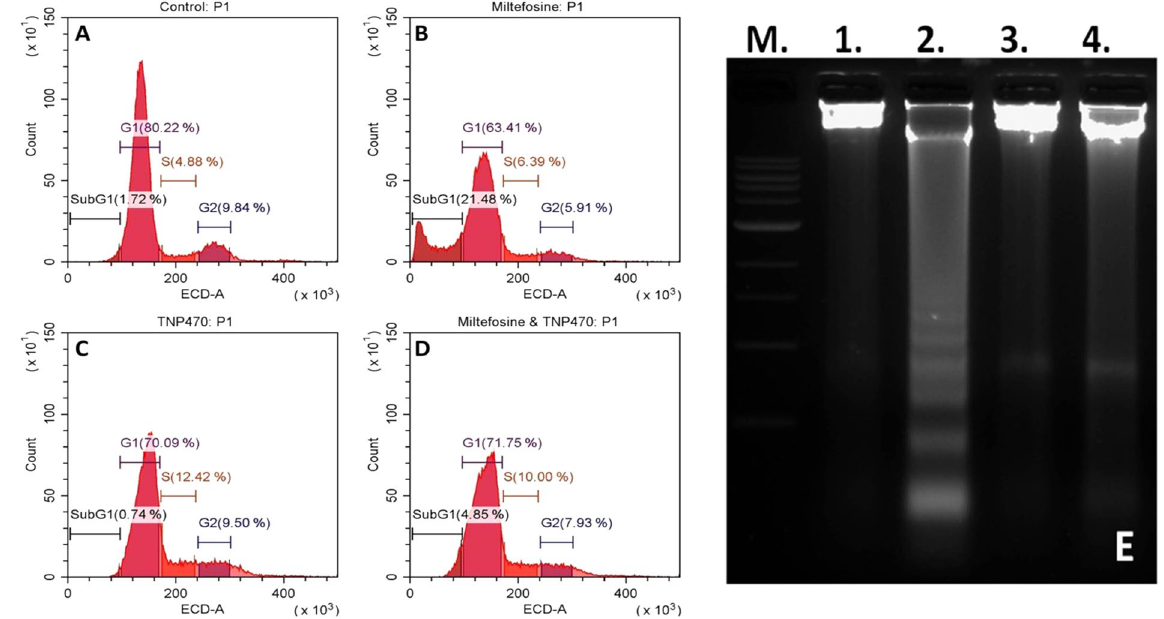
Figure 3. Cell cycle and DNA fragmentation analysis of L. donovani promastigotes. ( A ) Control promastigotes treated with 0.2% DMSO. ( B ) Promastigotes induced with 25 µ M of miltefosine. ( C ) Cells treated with 20 µ M of TNP-470. ( D ) Miltefosine induced promastigotes treated by TNP-470. ( E ) L. donovani genomic DNA fragmentation assay. Lane M. 1 kb ladder, Lane 1. Control cells (0.2% DMSO), Lane 2. Miltefosine induced promastigotes showing fragmentation of genomic DNA, Lane 3. TNP-470 treated, showing no fragmentation of genomic DNA, Lane 4. Both miltefosine and TNP-470 treated cells (showing inhibition of genomic DNA